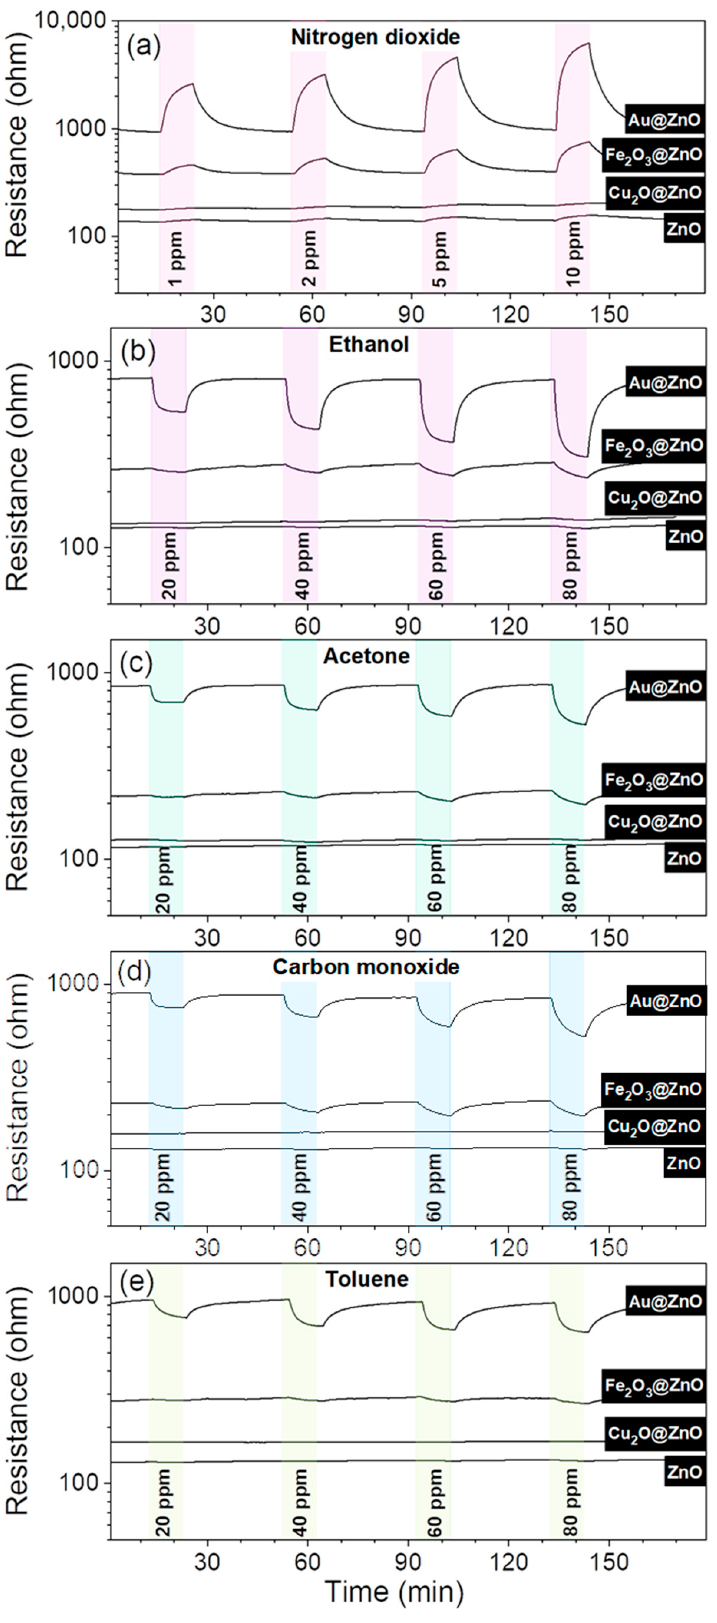
Figure 12. Electrical resistance changes to various concentrations of ( a ) nitrogen dioxide, ( b ) ethanol, ( c ) acetone, ( d ) carbon monoxide, and ( e ) toluene.